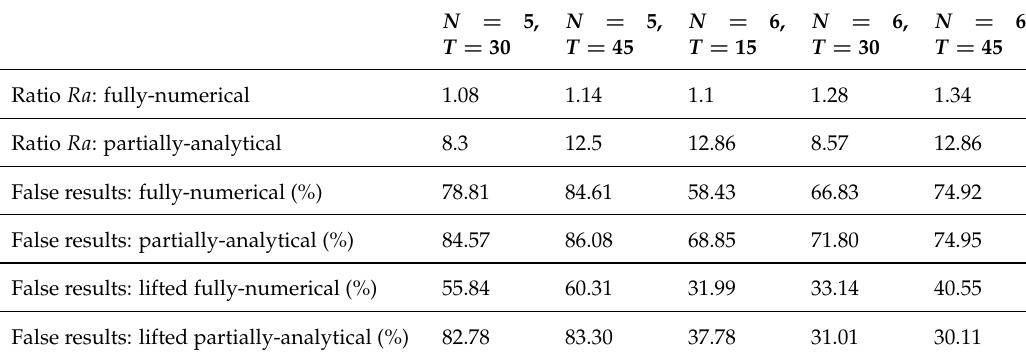
Table 10. Self-calibration results are based on a 2D model of synthetic LPM measurements where the offset is eliminated by forming a pairwise difference of measurement equations. The identified false optimizations have an error larger than